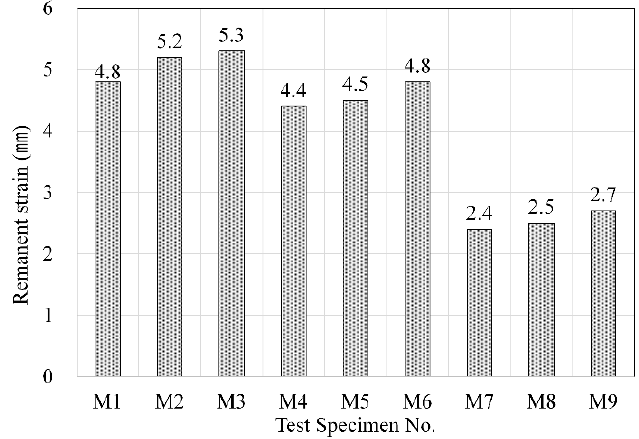
Figure 10. Variations of remanent strain according to mixing conditions.